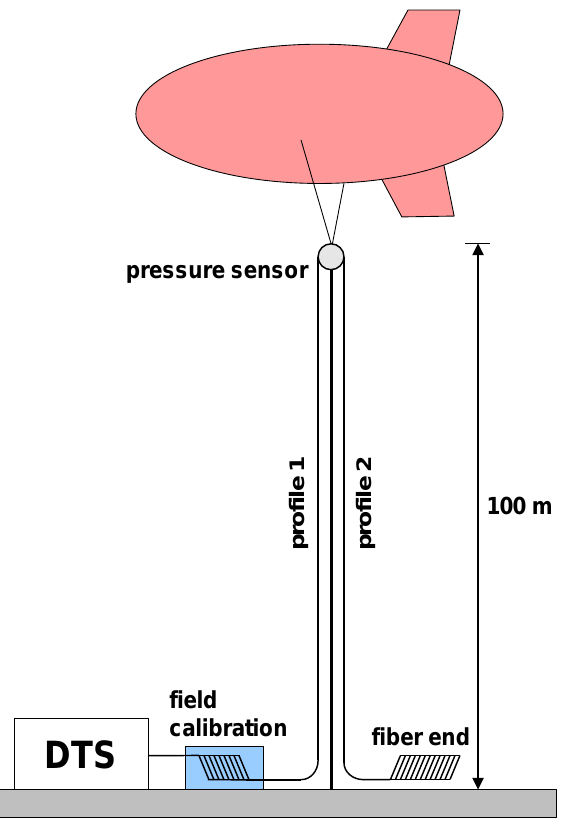
Fig. 1. Illustration of the experimental